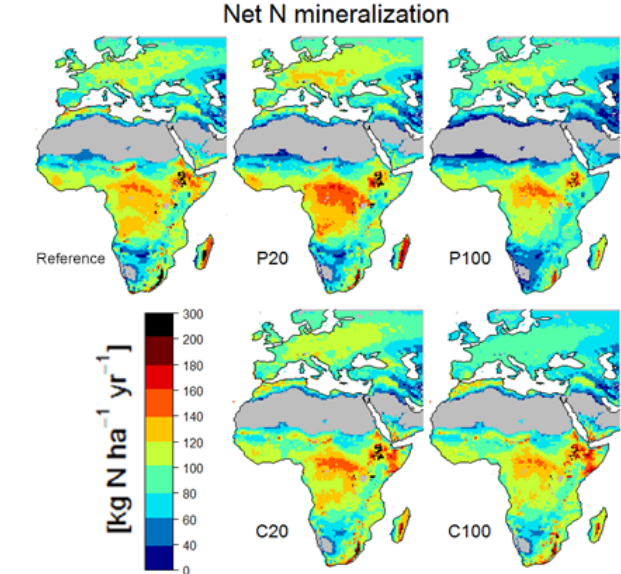
Figure 5. Average N limitation on vegetation RuBisCO capacity (and thus on gross primary production) for the reference simulation (full simulation period) and during the first 100 years of regrowth for the P20, P100, C20, and C100 simulations. N limitation is a number scaling from 0 (completely N-limited) to 1 (no N limitation) (Smith et al.,